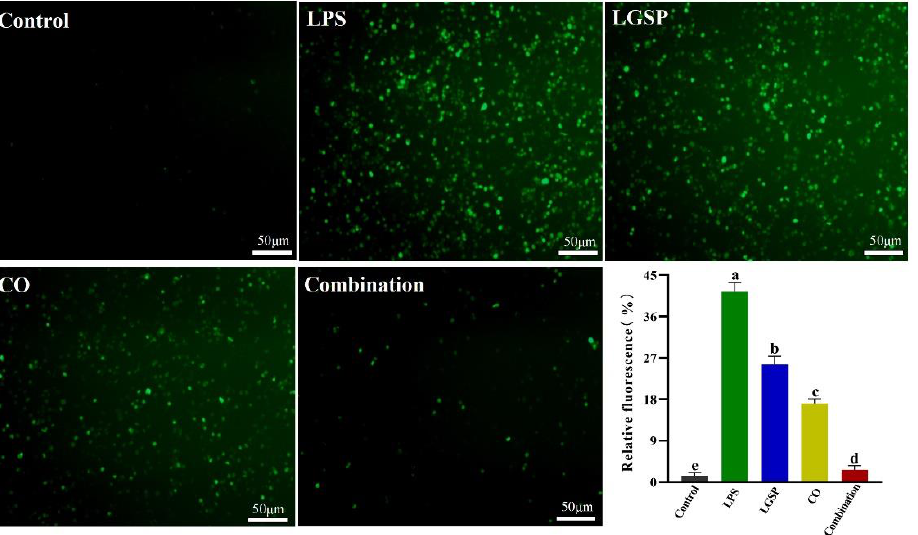
Figure 5. Effect of LGSP (20 µ g/mL), CO (1 mg/mL) and their combination on ROS in LPS-induced RAW264.7 cells. All values are means ± SD, n = 3. Different letters above the bars indicate significant differences ( p < 0.05).